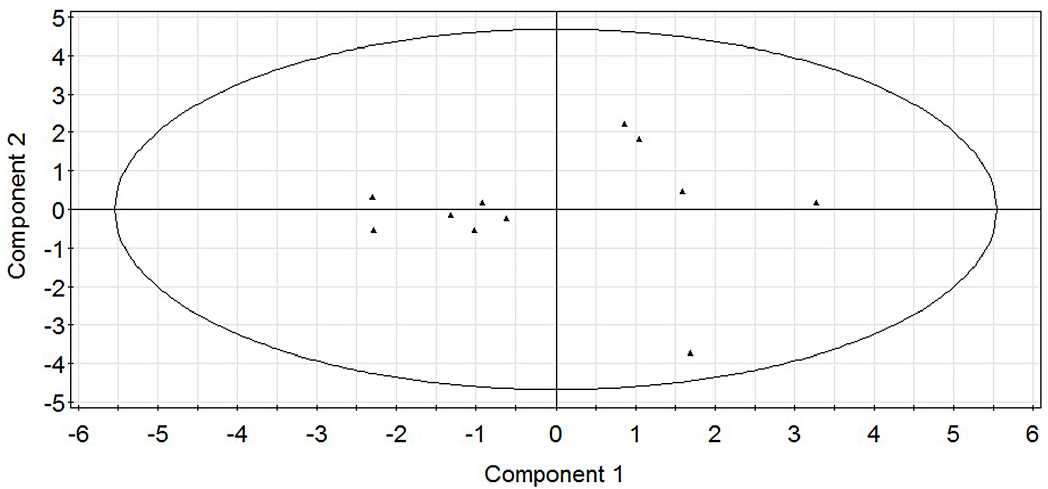
Figure 11. PLS-QSAR score plot.